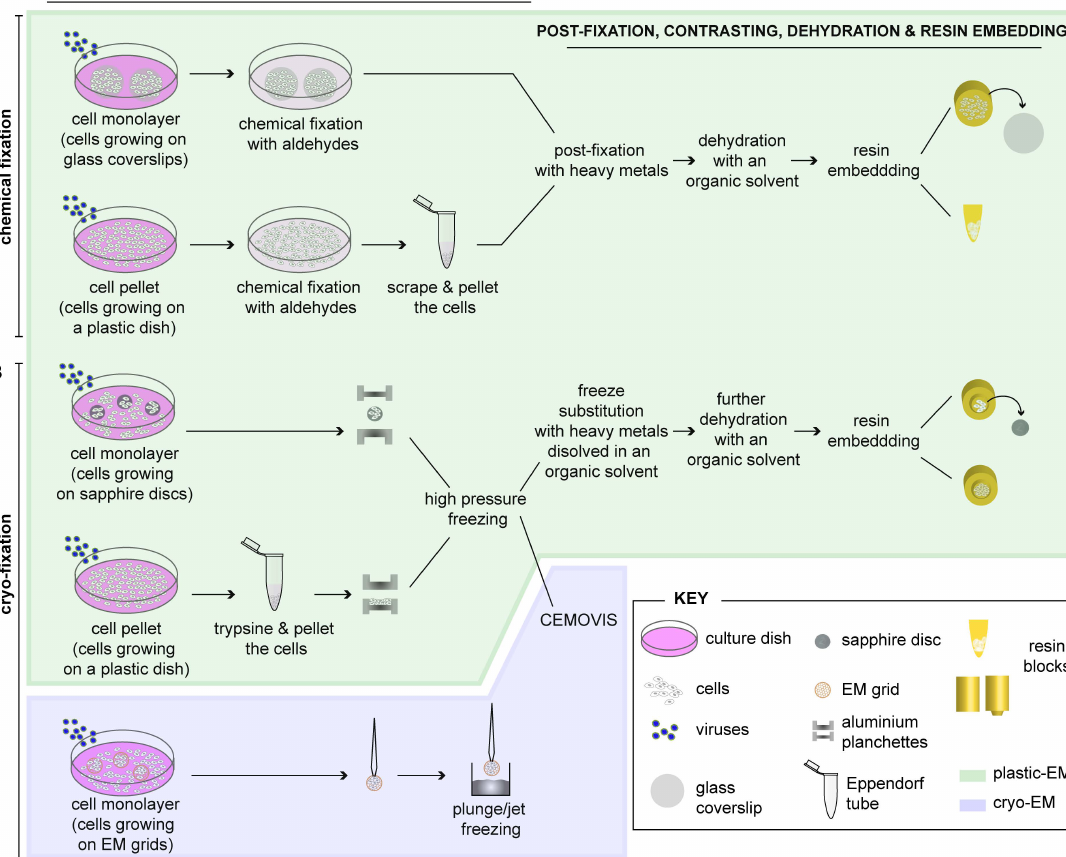
Figure 1. Schematic representation of the different methods for preparing virus-infected cells for electron microscopy (EM). Adherent cells can be either chemically fixed with aldehydes ( A ) or fast frozen by high-pressure freezing (HPF) or plunge/jet freezing ( B ). ( A ) After chemical fixation, infected cells can be further processed as a cell monolayer (grown on glass coverslips) or be pelleted prior to further processing for EM. Post-fixation is done with heavy metals (e.g., osmium tetroxide (OsO 4 ) and uranyl acetate (UA)), samples are dehydrated with increasing concentrations of an organic solvent (e.g., ethanol or acetone) and embedded into a plastic resin (plastic-EM; highlighted in green). Coverslips must be removed from the polymerized resin block by successive immersions in liquid nitrogen and hot water; ( B ) For rapid immobilization of cells by HPF, they must be grown as monolayers on sapphire (or aclar, not shown) discs, which are clamped in-between two aluminium planchettes and then loaded into a HPF machine for rapid freezing. Alternatively, cell pellets are directly placed into the aluminium planchettes or into capillary tubes (not shown) for freezing. Frozen cells can be subjected to freeze substitution (FS), dehydration with an organic solvent and resin embedding (plastic-EM; highlighted in green). Alternatively, high-pressure frozen cell pellets can be further analyzed by CEMOVIS (cryo-electron microscopy of vitreous sections) (cryo-EM, highlighted in violet). Cells growing on EM grids can be also plunge/jet frozen and analyzed directly by cryo-EM (highlighted in violet). Both cryo-EM approaches, which do not require further processing of the cells, allow visualizing cells in their closest-to-native status. Further details about these approaches can be found in the main text.